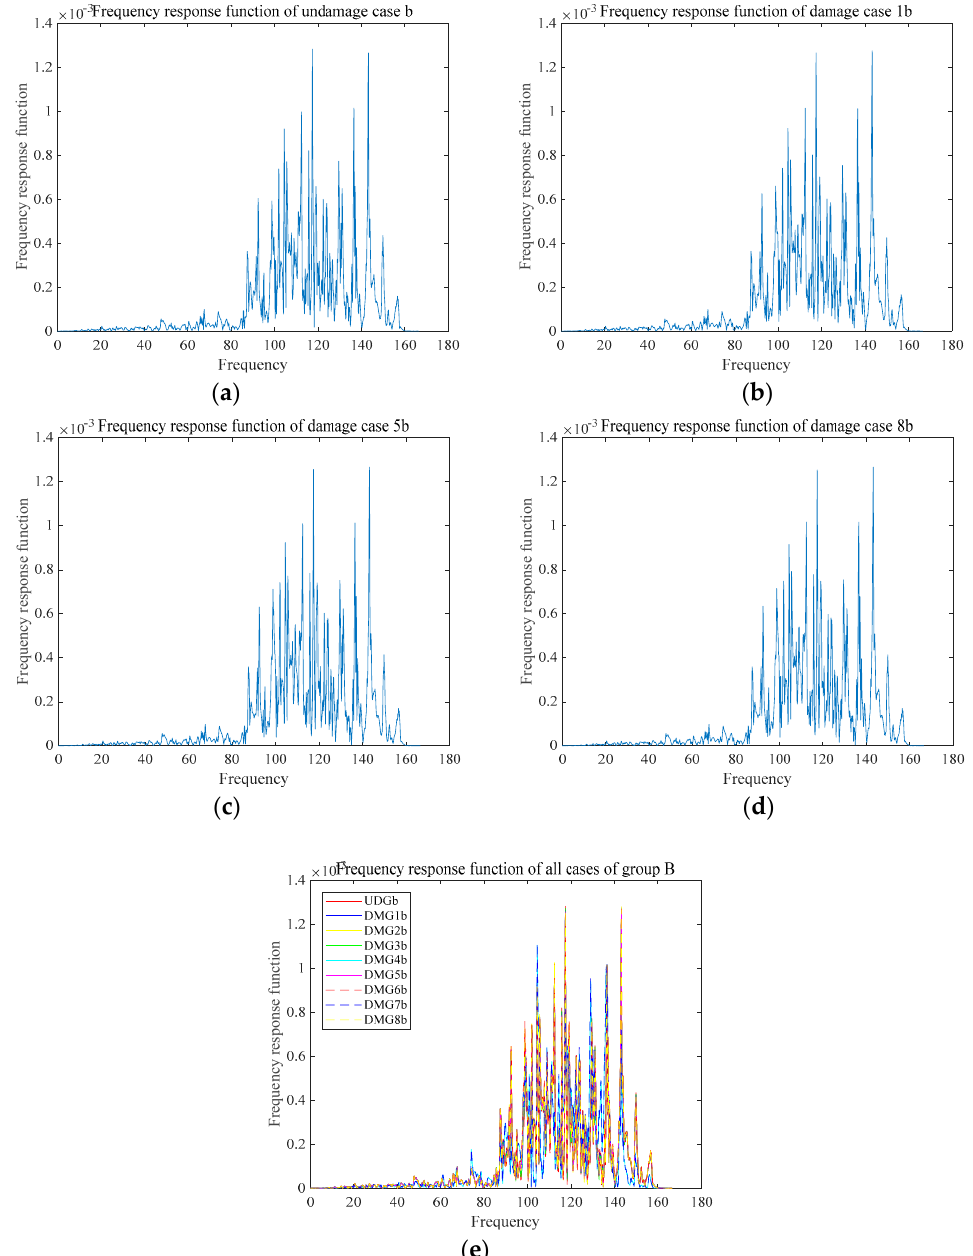
Figure 14. Frequency response function of Group B: ( a ) UDMb; ( b ) DMG1b; ( c ) DMG5b; ( d ) DMG8b; and, ( e ) all cases.